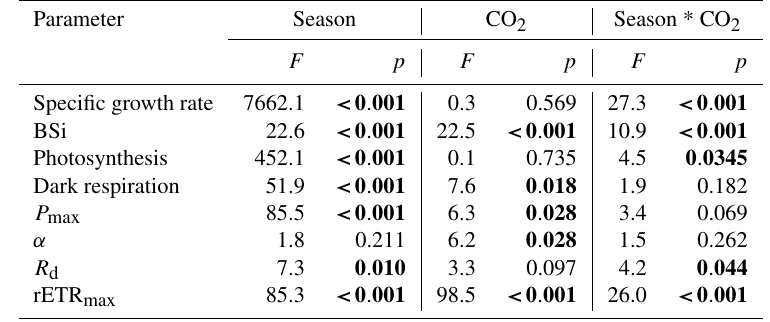
Table 1. Significance test results of growth, BSi, photosynthetic and respiration rates, parameters of P – I ( P max is the maximum net photo- synthetic rate, α is the photosynthetic efficiency, R d is the dark respiration rate), and RLC curves (rETR max , which is the maximum relative electron rate) for a combination of temperature and photoperiod (season), CO 2 , and their interactions.